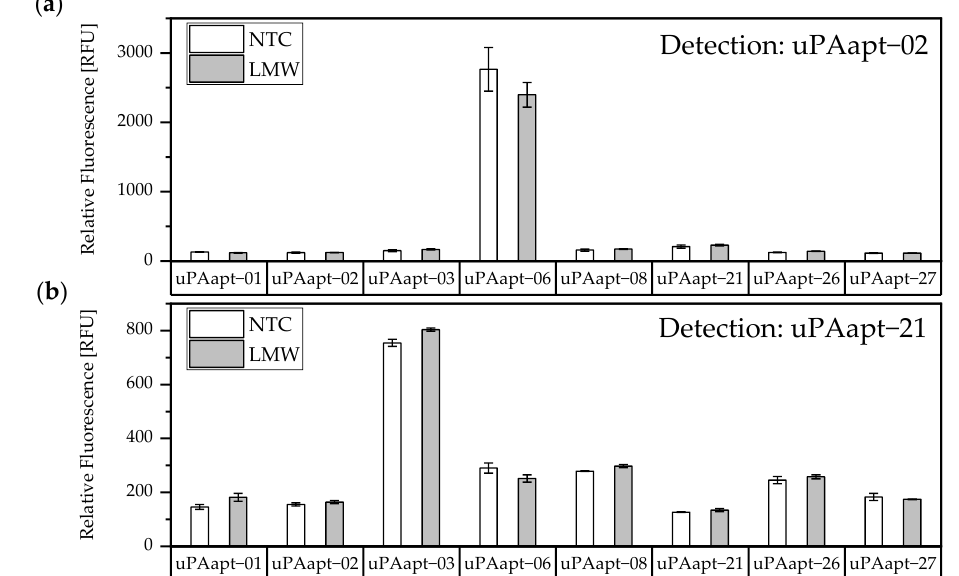
Figure 4. Screening for possible aptamer combinations for detection of LMW-uPA. All aptamers were tested for their use as capture aptamers when ( a ) uPAapt−02 or when ( b ) uPAapt−21 is used as the reporter aptamer. The relative fluorescence unit [RFU] for each sample is shown as the mean value of technical replicates and was measured using the multimode microplate reader Mithras 2 LB 943. Error bars represent the range of measured values. NTC = No Target Control, HMW = HMW-uPA. Number of records n = 2.